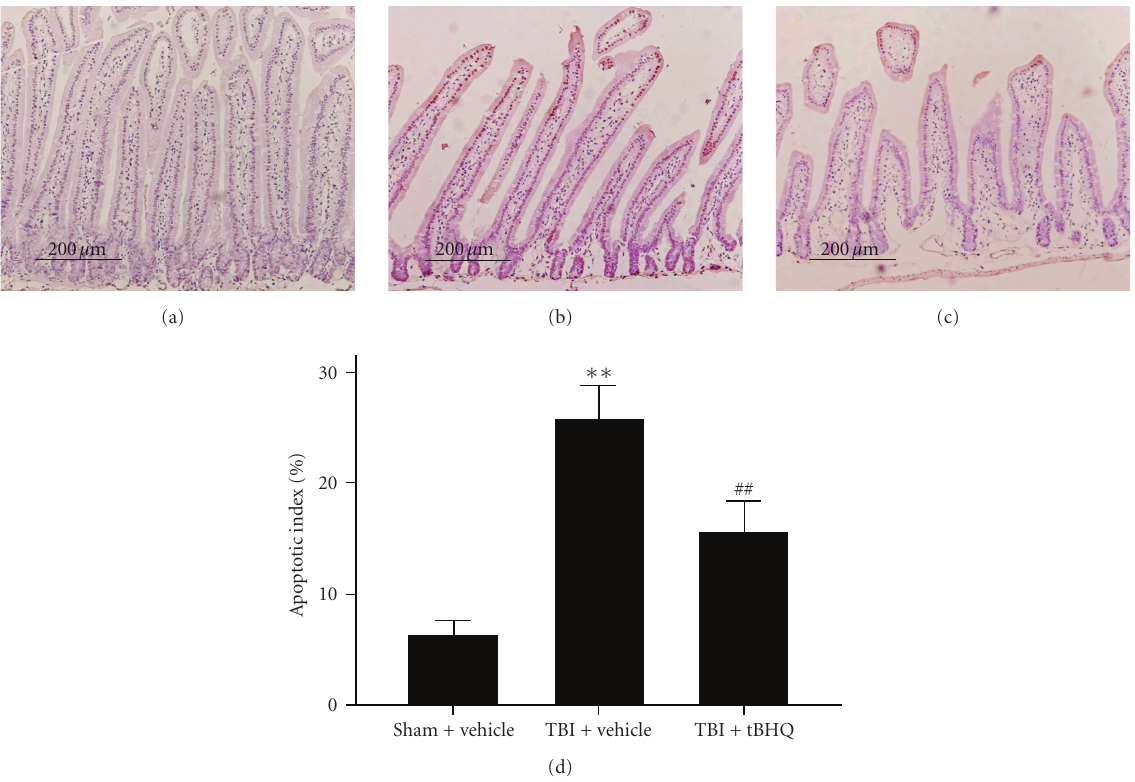
Figure 4: TUNEL immunohistochemistry staining in the intestinal tissue in sham + vehicle group, TBI + vehicle group, and TBI + tBHQ group ( n = 6). (a) sham + vehicle group mice showing few TUNEL positive cells (stained brown); (b) TBI + vehicle group mice showing more TUNEL positive cells; (c) TBI + tBHQ group mice showing less TUNEL positive cells than TBI + vehicle group; (d) tBHQ treatment significantly decreased the apoptotic index in the intestinal tissue following TBI. ∗∗ P < . 01 versus sham + vehicle group; ## P < . 01 versus TBI + vehicle